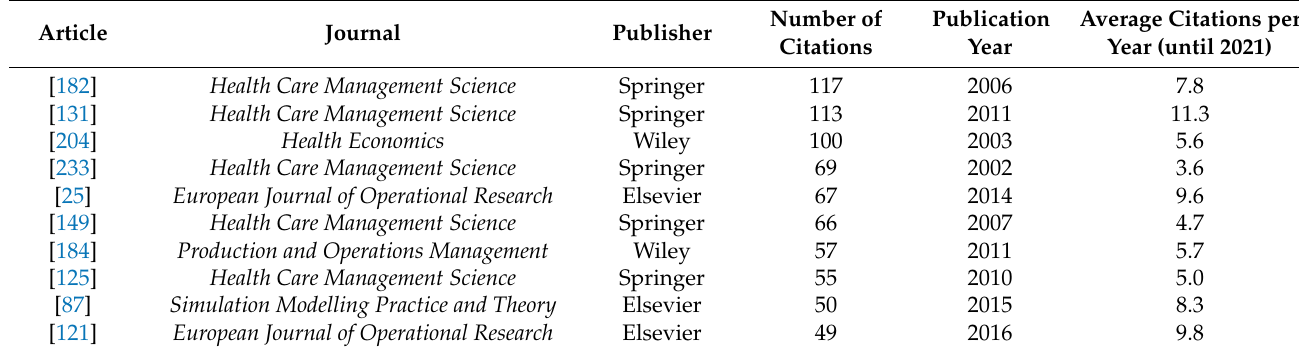
Table 5. Top DES publications by number of citations.